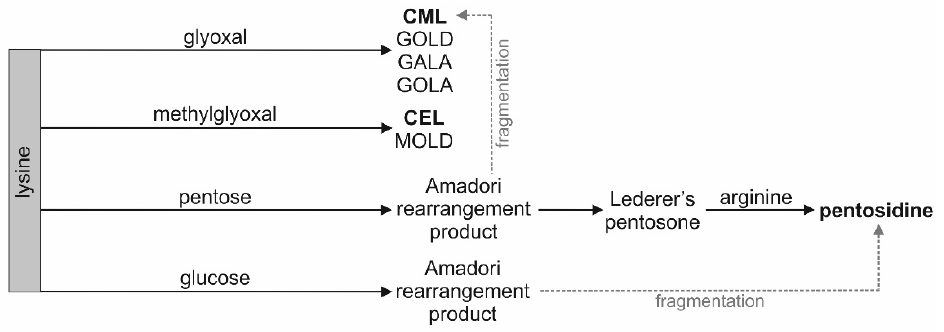
Figure 2. Simplified scheme of pathways leading to the formation of CML, CEL, and pentosidine (bold text). GALA—glycolic acid lysine amide, GOLA—glyoxal lysine amide, GOLD—glyoxal lysine dimer, MOLD—methylglyoxal lysine dimer.